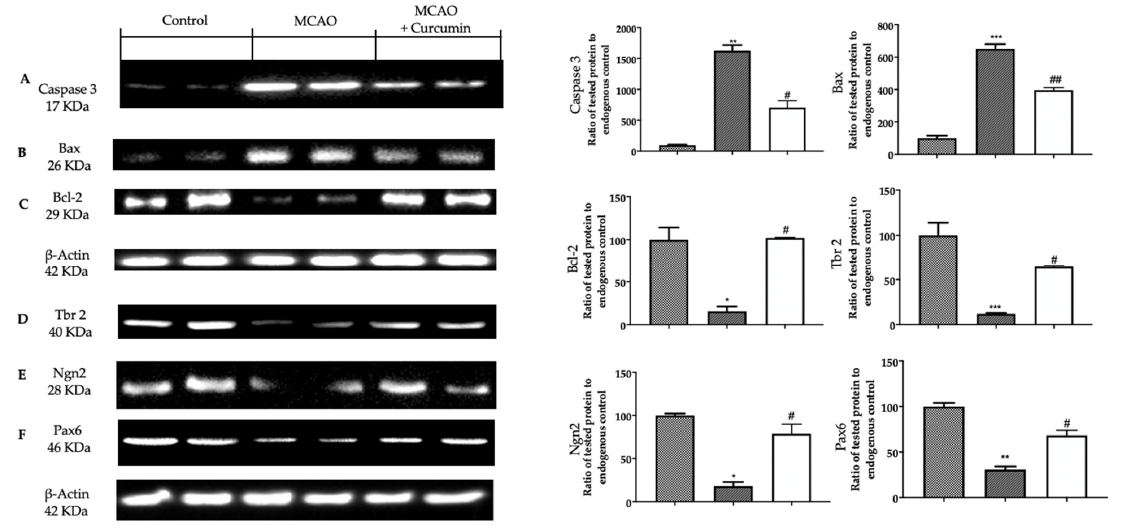
Figure 6. Analysis of apoptosis and neurogenesis in ischemic brain after curcumin administration: Western blot analysis of ( A ) Caspase 3, ( B ) Bax, ( C ) Bcl ‐ 2, ( D ) Tbr 2, ( E ) Ngn 2, ( F ) Pax 6. For these analyses, n = 5 animals for each group were employed. Data were analyzed by one ‐ way ANOVA followed by a Bonferroni post hoc test for multiple comparisons. A p ‐ value of less than 0.05 was considered significant: * p < 0.05 versus sham; ** p < 0.01 versus sham; *** p < 0.001 versus sham; # p < 0.05 versus MCAO; ## p < 0.01 versus MCAO; ### p < 0.001 versus MCAO.